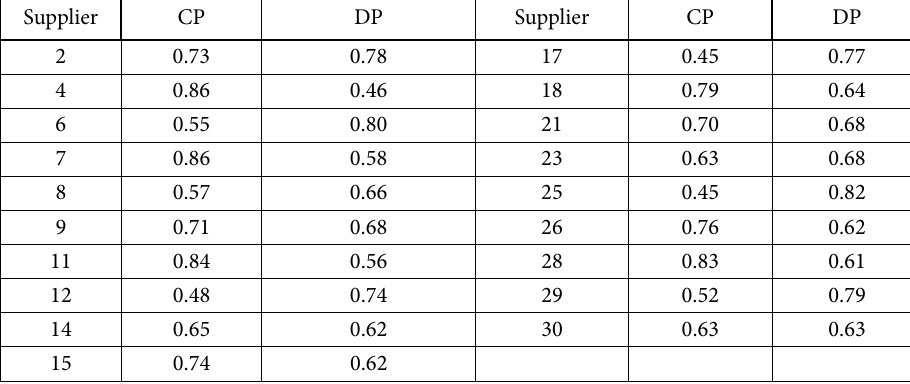
Table 28. Comparative and diversity performance for oxygen sensor